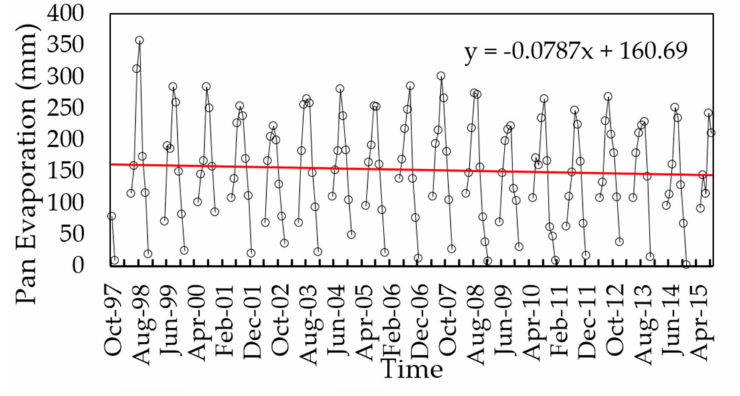
Figure 7. Time series and linear trend analyses of sunshine duration data between 1997 and 2015.